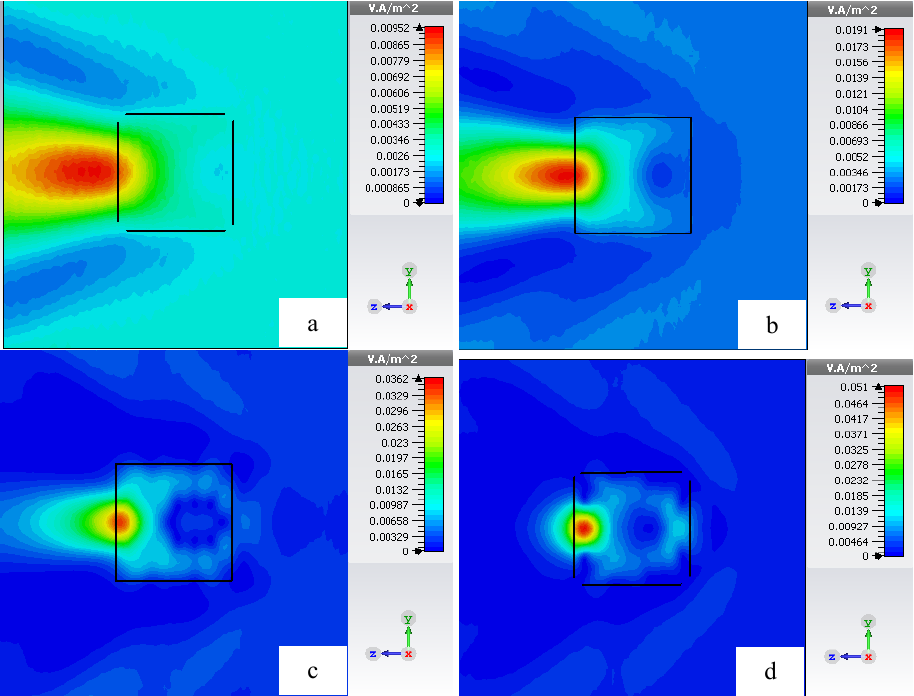
Fig. 1. The distribution of the electromagnetic field in the near zone of the dielectric cube at a frequency of 42 GHz: A) n = 1.2; B) n = 1.41; C) n = 1.73; D) n =